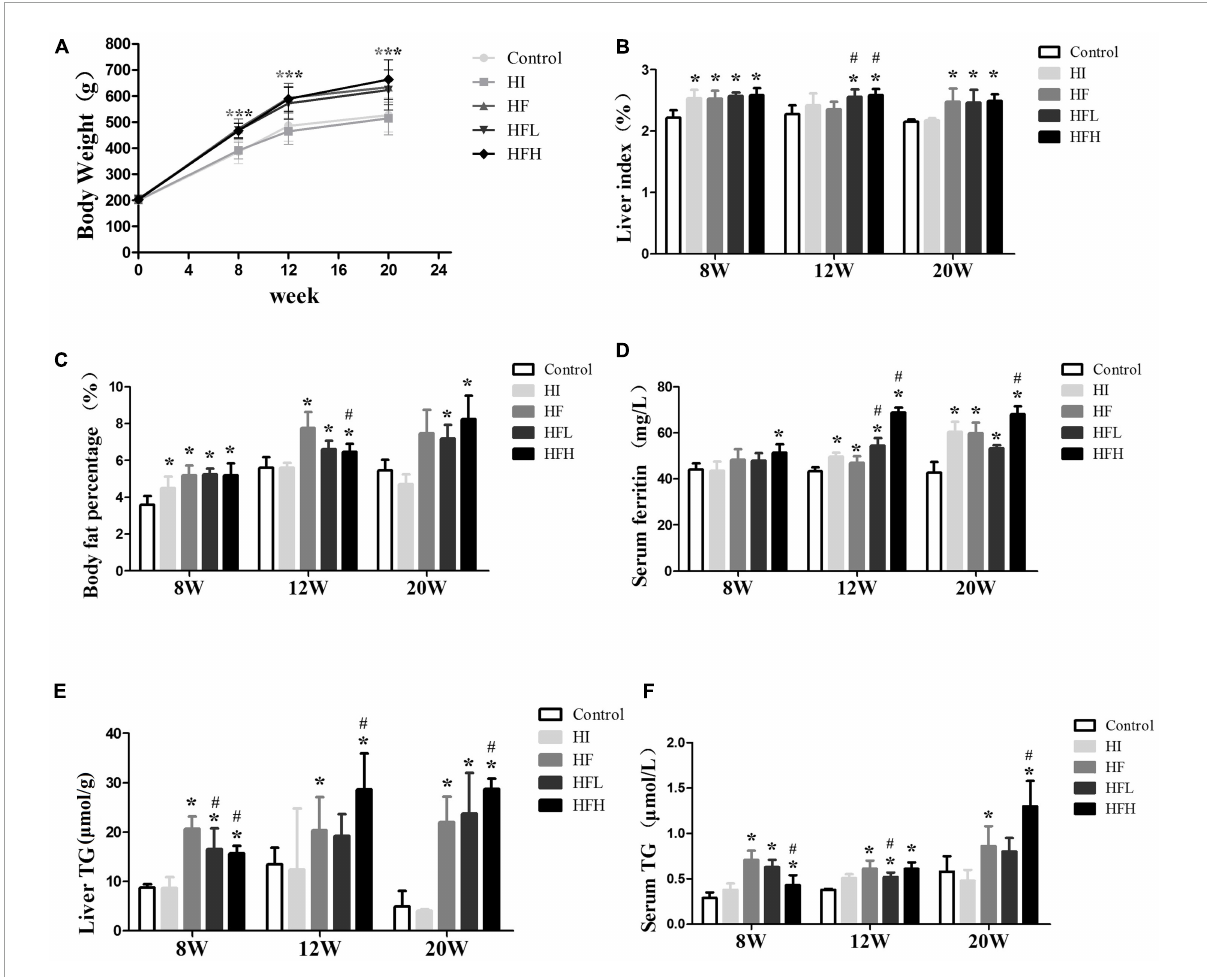
FIGURE1 Iron overload aggravated lipid accumulation induced by a HFD. (A) Body weight, (B) liver index, (C) body fat percentage, (D) serum ferritin, (E) liver TG, and (F) serum TG levels in serum in rats at 8, 12 and 20 weeks. * and # compared with control/high-fat group at the same time point, respectively, P < 0.05. Only one “* and ***” refers to the HF, HFL and HFH groups compared to the control group at the same time point, respectively, P <